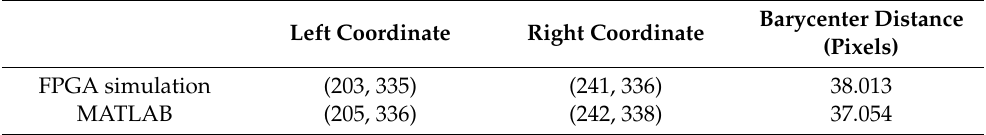
Table 1. Comparison table of the FPGA simulation and MATLAB calculation results. Left Coordinate Right Coordinate FPGA simulation